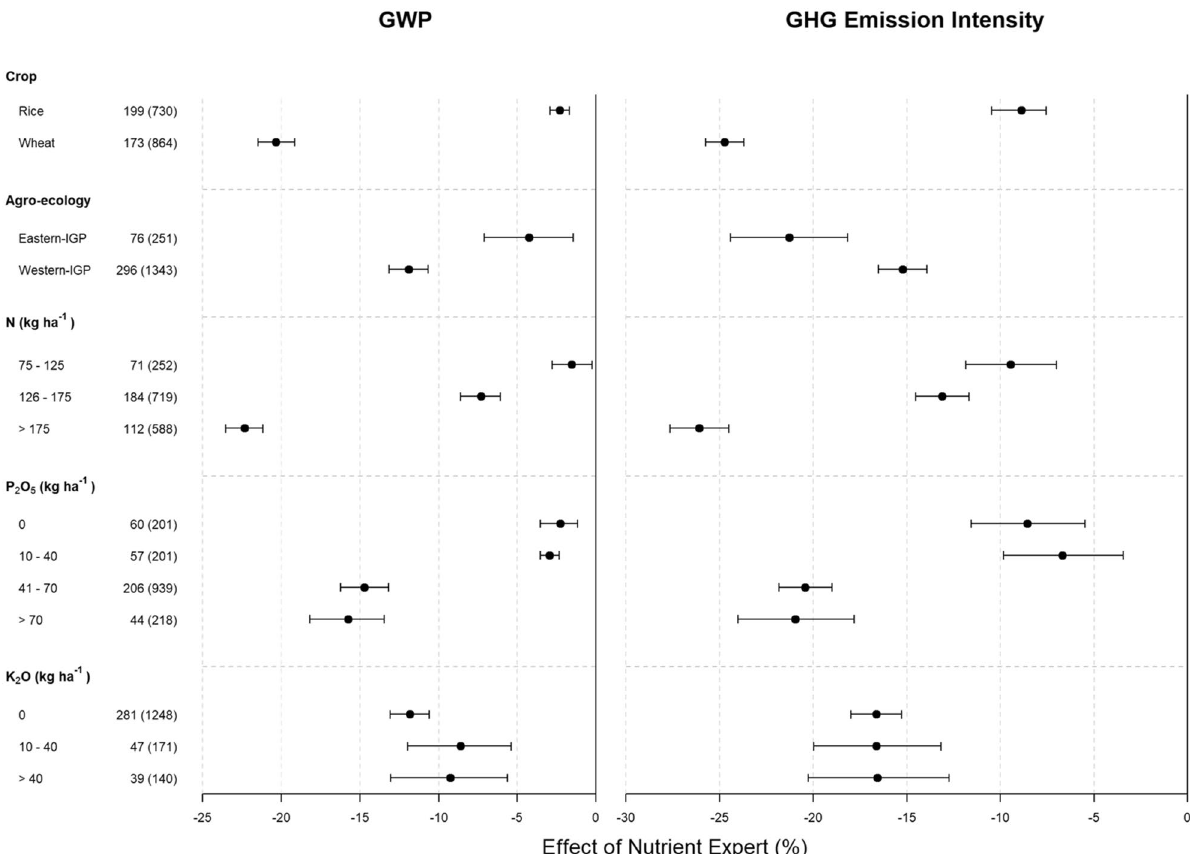
Figure 4. Percent change in global warming potential (GWP, left panel) and emission intensity (right panel) due to NE-based fertilizer management compared to FFP segregated by crop types, agro-ecological zones and farmers’ fertilizer application rates. In the Y-axis, the numbers outside parentheses denote the number of villages and the ones inside parentheses show the number of pairs analyzed. Error bars indicate 95% confidence intervals (CI). The changes are considered significant when 95% CI does not overlap zero, and the effects of categories within a parameter are significantly different when their 95% CI do not overlap with each other. IGP = Indo-Gangetic